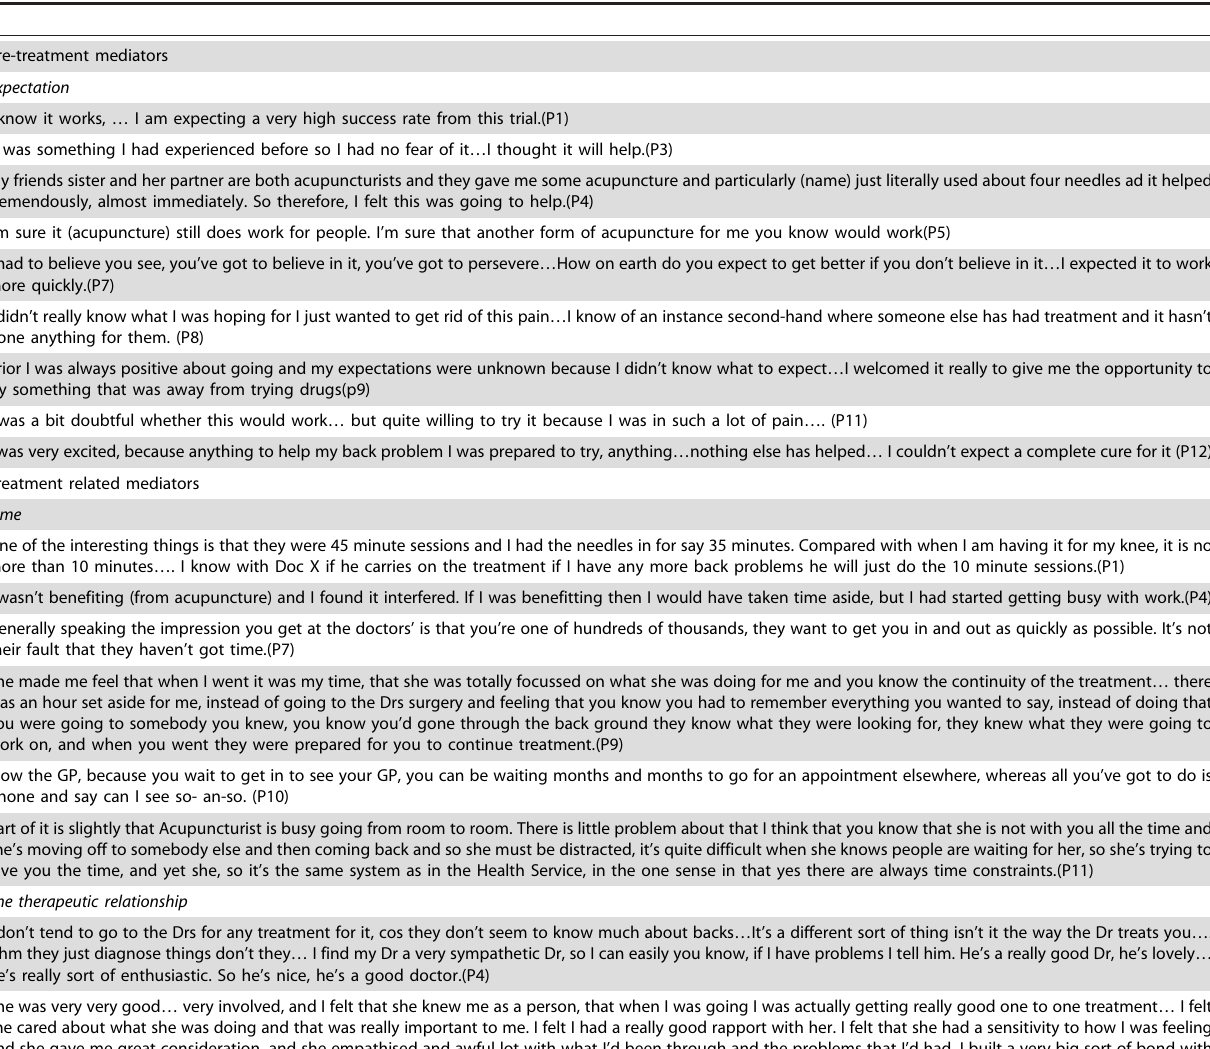
Table 3. Over-arching theme 3; Mediating